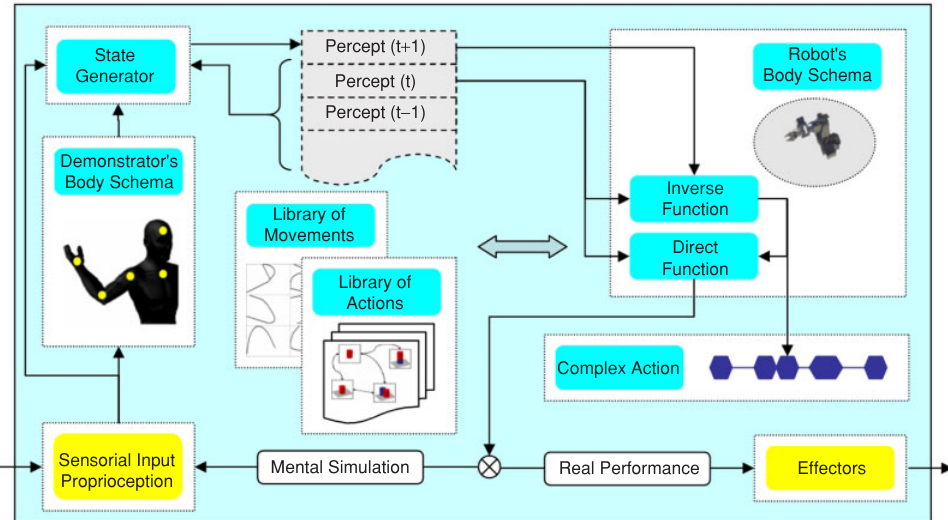
Figure 7 The interaction of the body percept and the body schema, when the robot system is learning. The output from an action can be inhibited to the effectors, which will produce a mental rehearsal of the